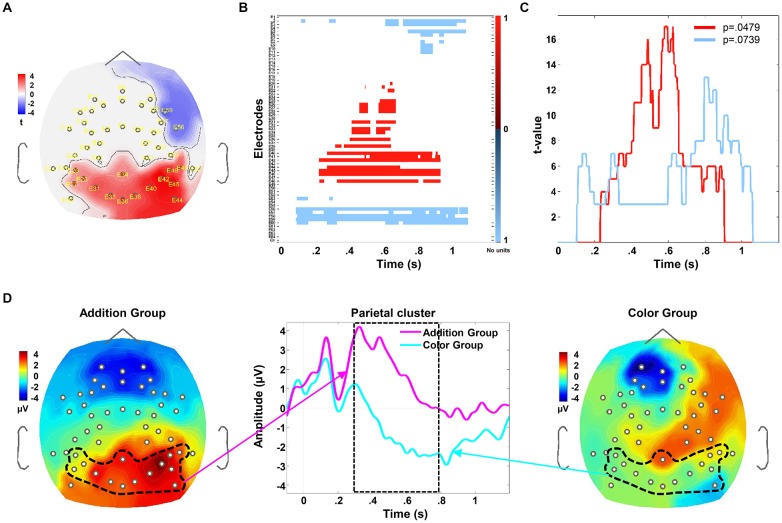
Spatiotemporal cluster for significant differences between Groups, regardless of Session and Type of Trial. Zero time indicates the N3’s onset. (A) Draws the scalp topography of the values of the Student’s t over the parietal and right-frontal clusters, averaged from 276 ms to 754 ms after the N3’s onset. In (A–C), the red color indicates a greater amplitude of the ERP response in the Addition than in the Color Group, while the blue color indicates the contrary. (B) Plots the variation in time of the t-value in each electrode. (C) Plots the cluster size, illustrating the variation in time of the t-values across all the electrodes of each cluster. The depicted p-values indicate the statistical probability for each spatiotemporal cluster that emerged when we compared differences between Groups. We further analyzed only the parietal cluster, with a p < 0.05. In (D), the middle figure plots the grand averages of the P2p amplitude for the Addition and Color Groups (in magenta and cyan lines, respectively). These means were computed by averaging the electrodes of the parietal cluster delimited by the black dotted in the voltage map images for the Addition-Group (left voltage map, magenta arrow) and Color-Group (right voltage map, cyano arrow), from 100 before to 1200 ms after N3’s onset. The dashed rectangle indicates the time window when Groups significantly differed in the parietal cluster.